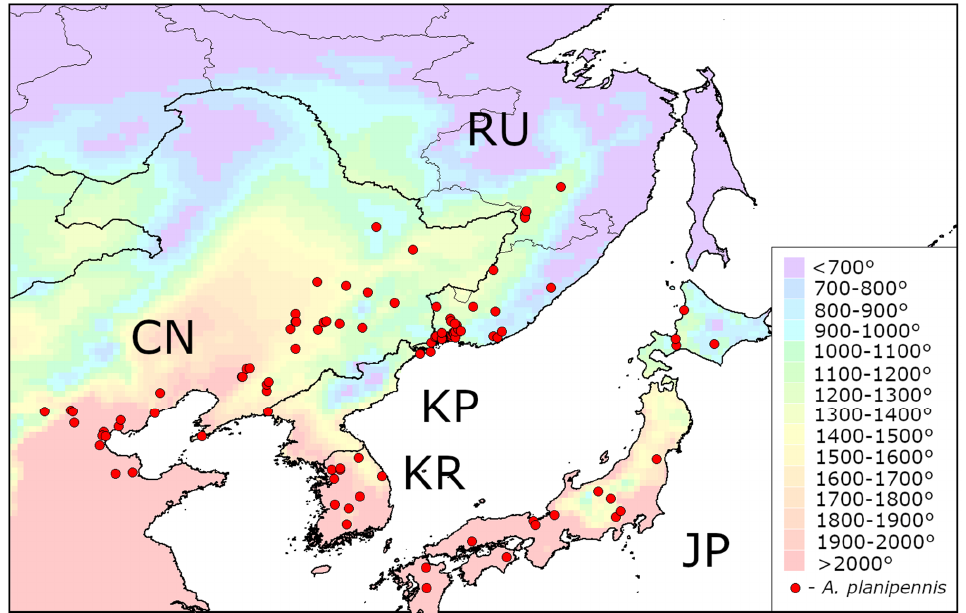
Figure 1. Heat availability in the native range of Agrilus. planipennis in Asia. Mean AGDD 10 per year in 2003–2020 is indicated with colours (see the legend). CN—China, JP—Japan, KP—Democratic People’s Republic of Korea, KR—Republic of Korea, RU—Russia. The information about occurrences of A. planipennis was obtained from the review of its native range [3].